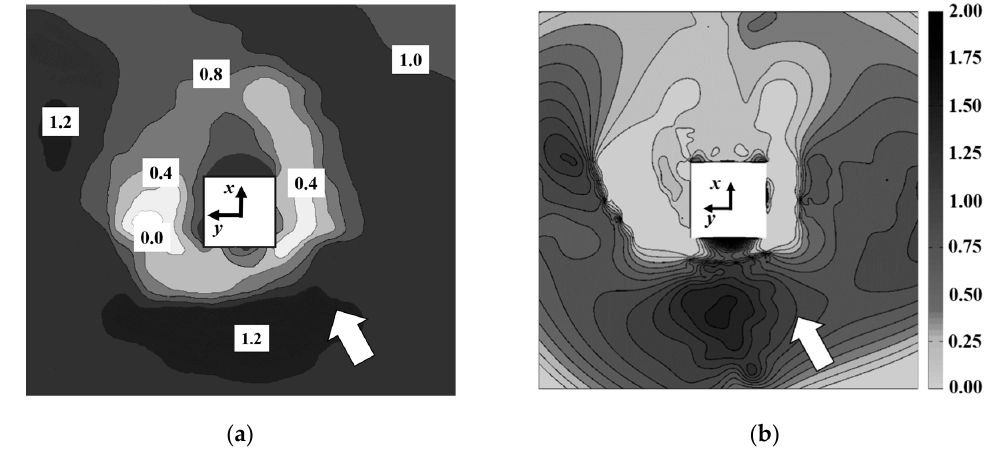
Figure 4. Comparison of horizontal distributions of normalized snow depths: ( a ) prototype result [18]; ( b ) experimental result.